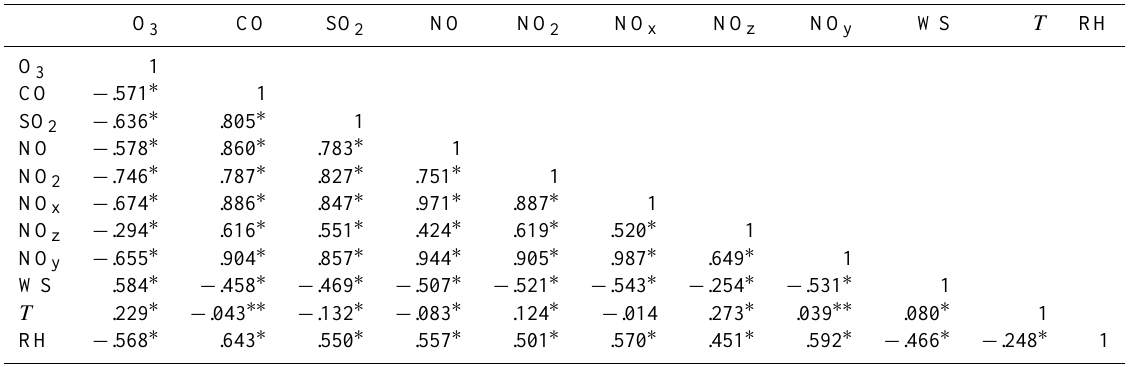
Table 1. Pearson’s correlation coefficients among gases and meteorological parameters. O 3 CO SO 2 NO NO 2 NO x NO z NO y